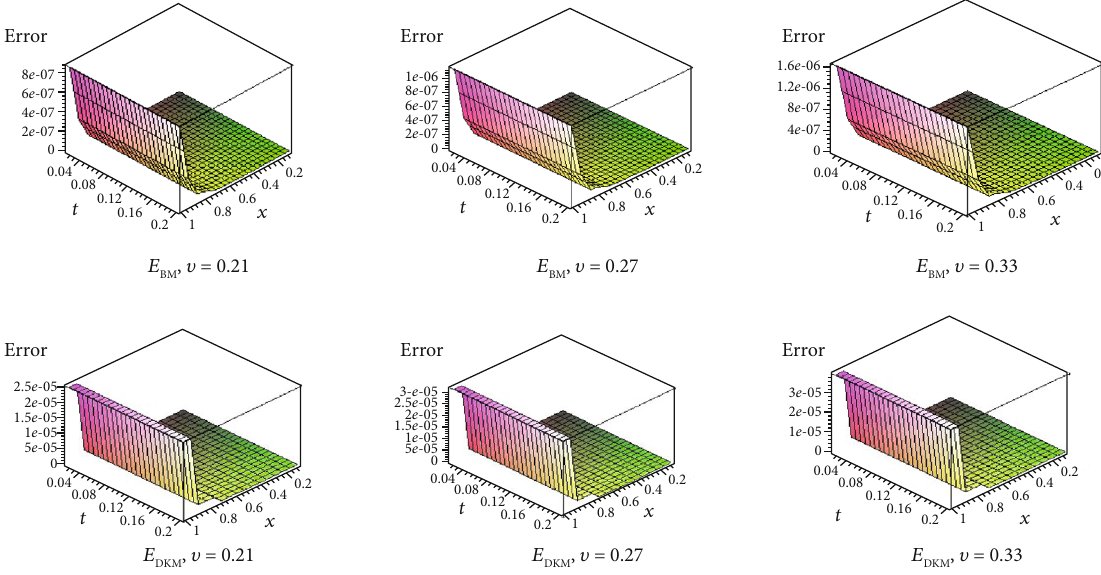
Figure 10: The values of errors by B-by-BM and DKM at T = 0 : 2 , N = 20 , and k = 2 for υ = 0 : 21, 0 : 27, 0 : 33